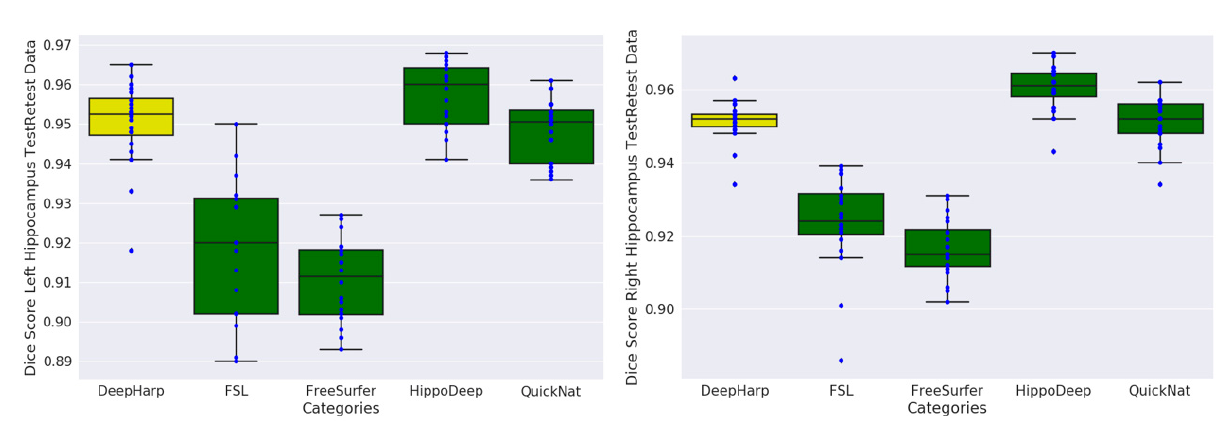
Figure 7. Comparison of DeepHarp robustness (based on Dice score) with common tools and state-of-the-art methods for hippocampus segmentation.